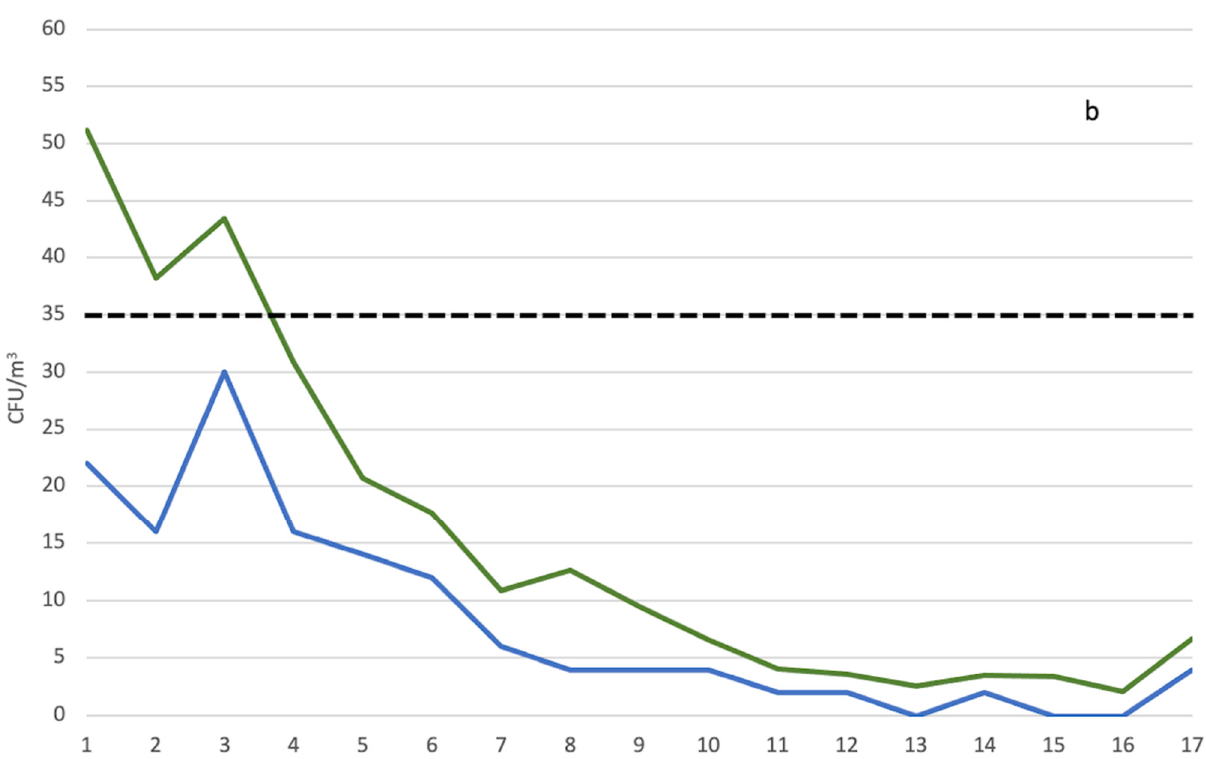
Figure 1. Mean and median bacterial load trends in the centre of the operating theatre in operational ( a ) and at rest conditions ( b ) during the year of observation. The horizontal dotted line refers to the Italian guidelines’ reference values (180 CFU/m 3 and 35 CFU/m 3 , respectively).